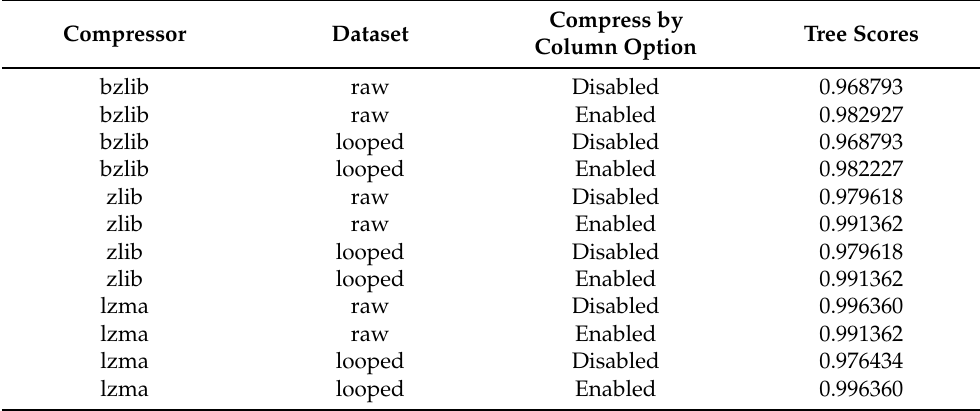
Table 5. Comparison of tree scores obtained using two types of datasets: raw and looped dataset, with and without the option of compression by column being active. The compressors used are the ones inbuilt into the original Complearn tool [16].